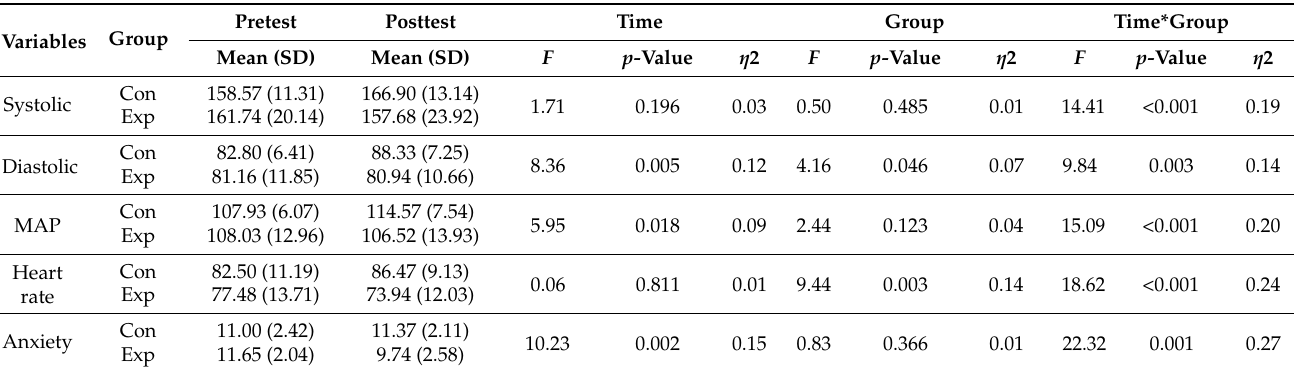
Table 4. Descriptive statistics and effects of intervention in control and experimental groups over time.